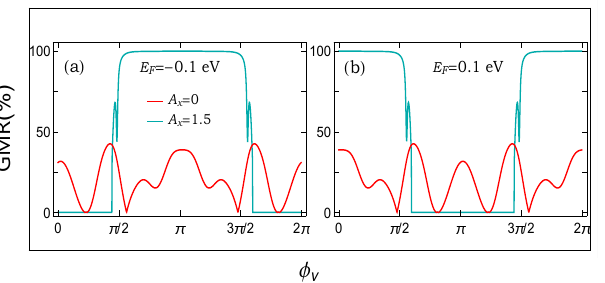
Figure 4. ( a , b ) (Color Online). Variation in GMR with the AAH phase φ ν at two different Fermi energies both in the absence and presence of light irradiation.